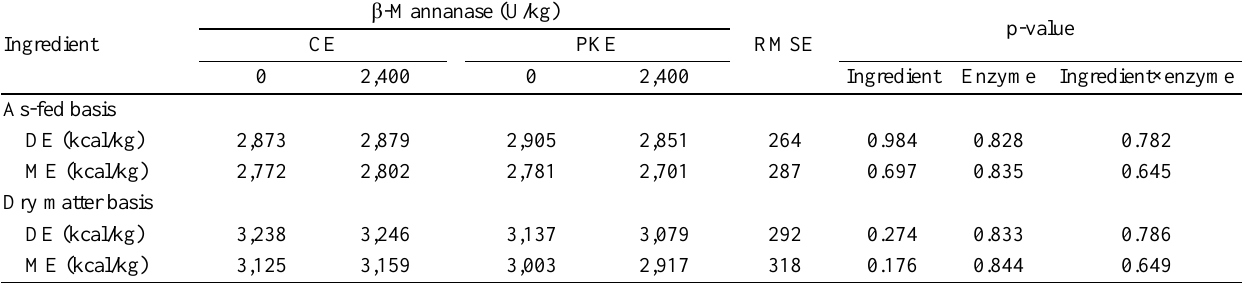
Table 4. Energy values for copra expellers (CE) and palm kernel expellers (PKE) fed to pigs 1